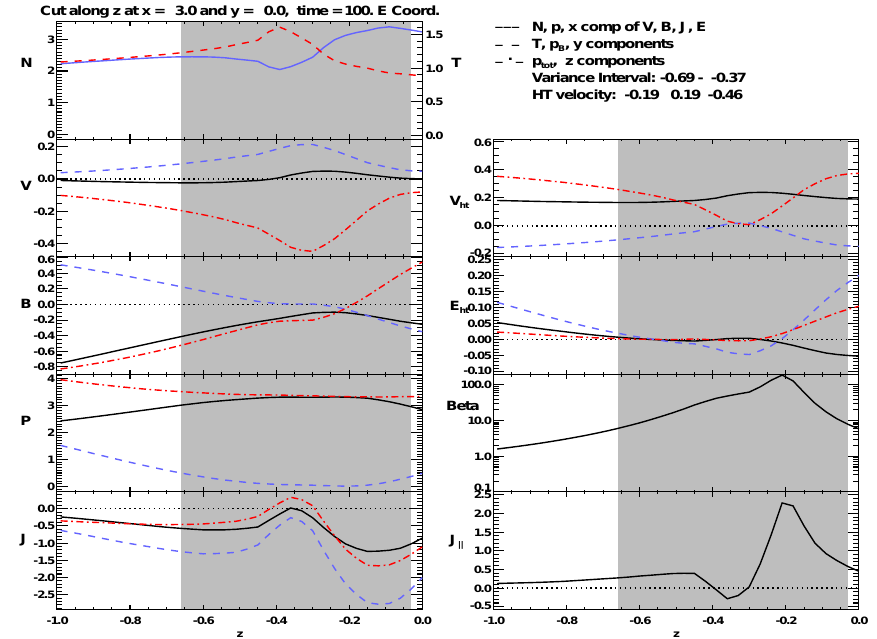
Fig. 13. Simulated “data” transformed into MVAE boundary normal coordinates for the inner boundary transition. All quantities are plotted in normalized simulation units. Plotted in the left column from top to bottom are the density (solid blue line) and temperature (dashed red line), velocity components (x – solid black, y – dashed blue, z – dash-dot red), magnetic field components, pressure (thermal pressure – black, magnetic pressure – blue, total pressure – red), and current density components. The right column displays the velocity and electric field components in the deHoffman-Teller frame, plasma β , and the parallel current density.